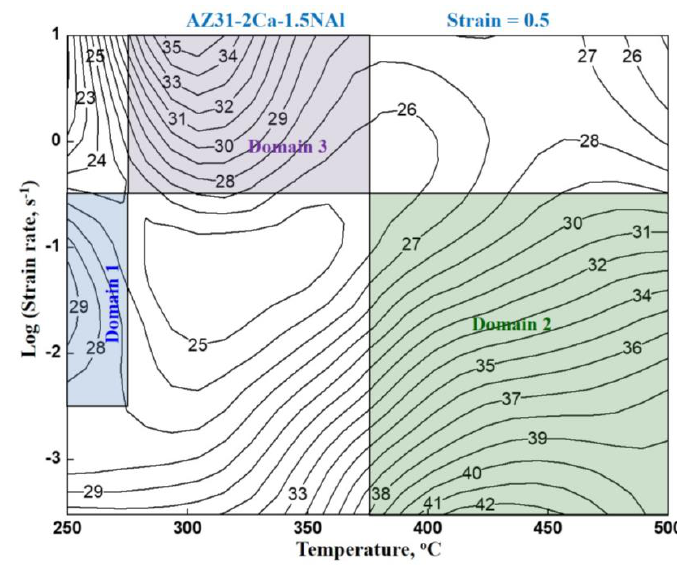
Figure 5. Processing map for hot working of DMD-processed AZ31-2Ca-1.5NAl composite obtained at a true strain of 0.5. The numbers associated with the contours indicate efficiency of power dissipation in percent.